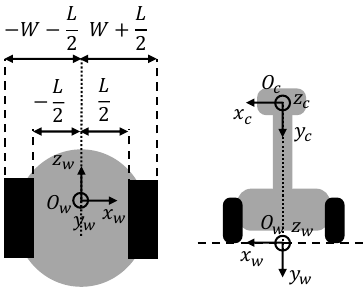
Figure 10. Mobile robot carrying a camera and layout of both world and camera reference